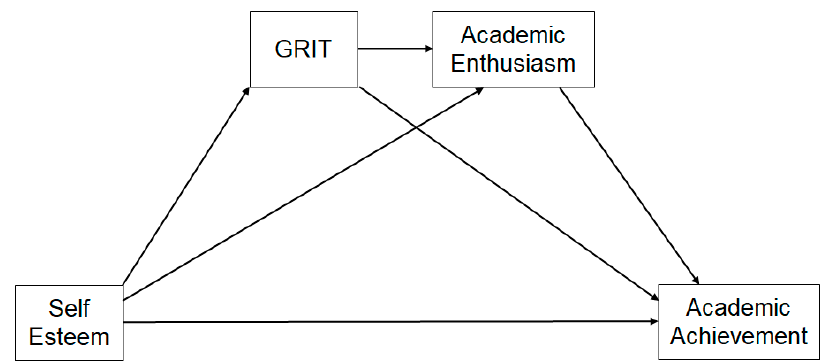
Figure 1. Research